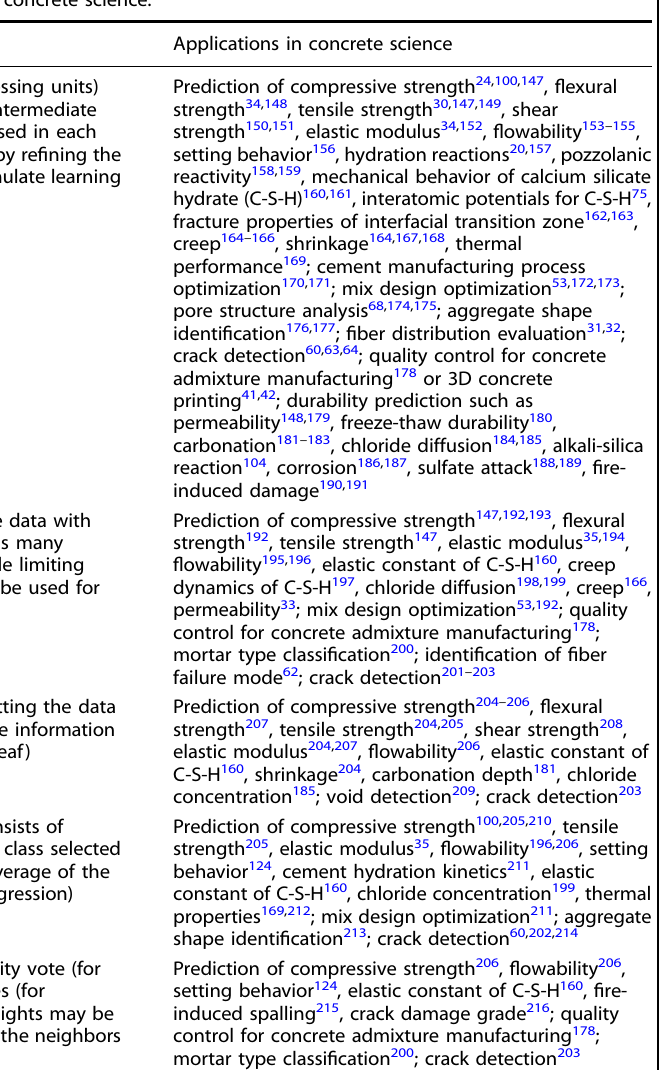
Table 1. Summary of applications of machine learning (ML) models in concrete